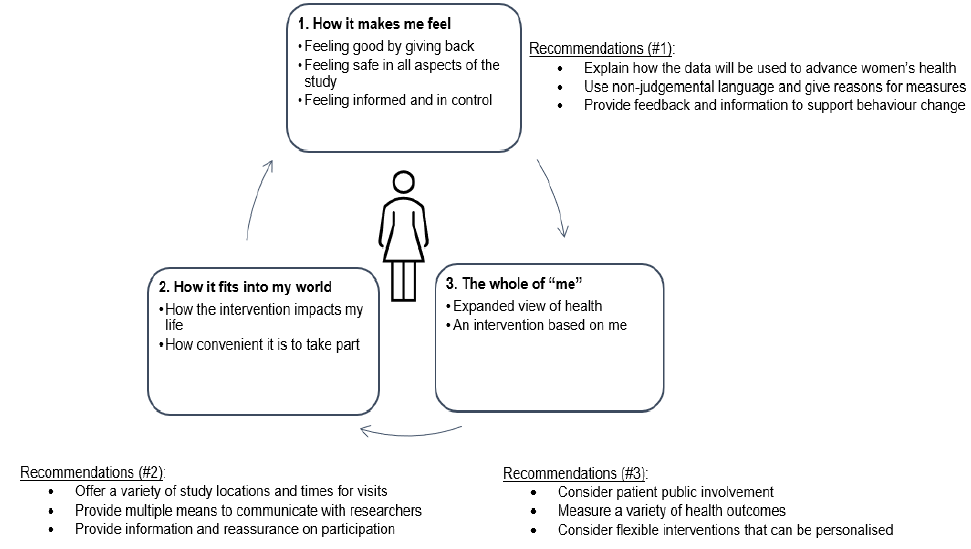
Figure 2. Themes and subthemes relating to taking part in research and recommendations for clin- clinical ical trialists.